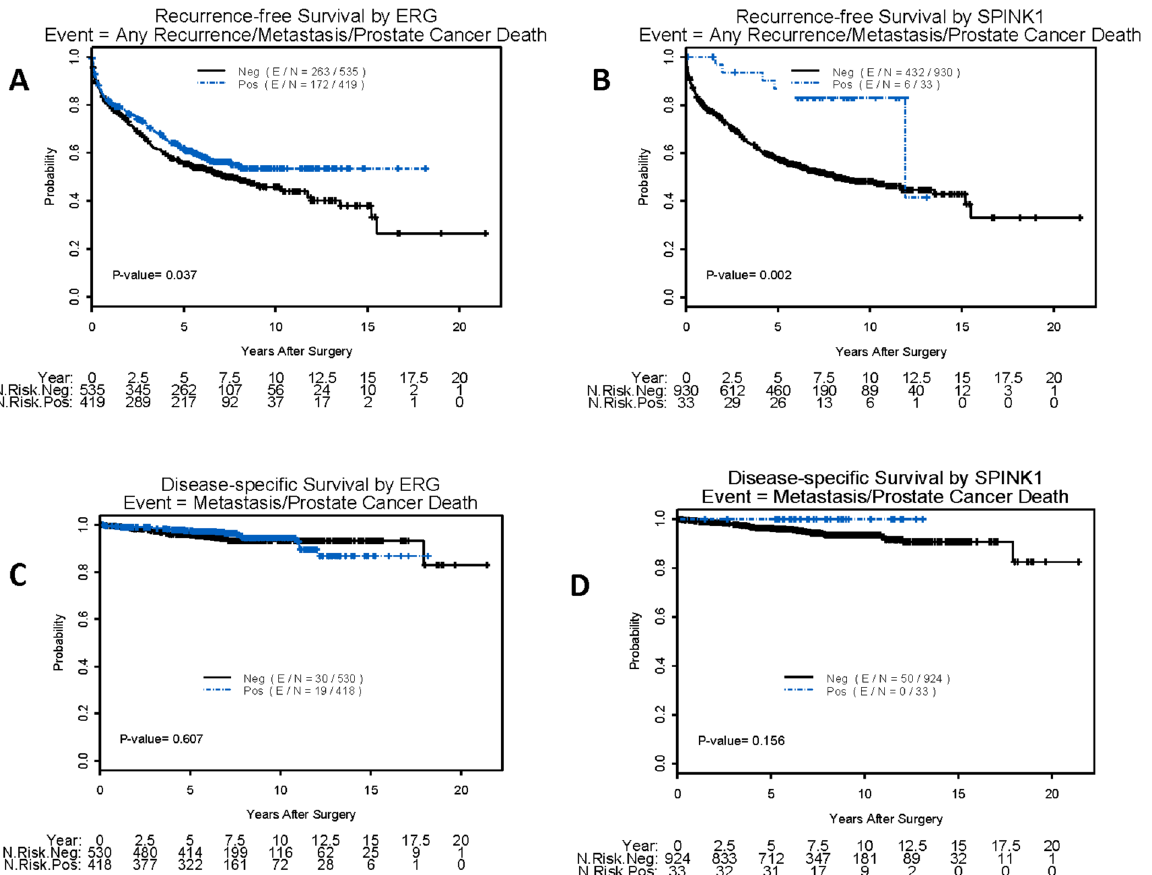
Fig 2. Kaplan-Meier plots of showing the relationship of expression of ERG or SPINK1 and clinical outcome: A) High expression of ERG is associated with improved RFS B) High expression of SPINK1 is associated with improved RFS C) High expression of ERG is not associated with diseases specific survival or development of metastases D) High expression of SPINK1 is not associated with diseases specific survival or development of metastases.